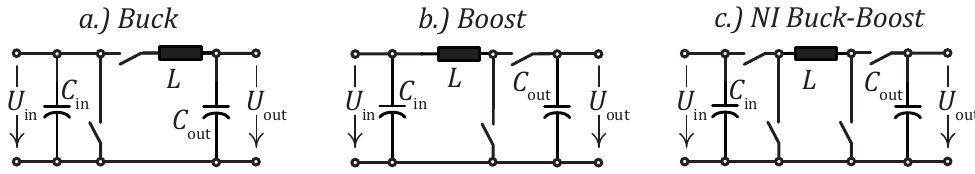
Figure 4. Considered DC–DC Converters: ( a ) Buck Converter; ( b ) Boost Converter; ( c ) Non-inverting (NI) Buck–Boost Converter.